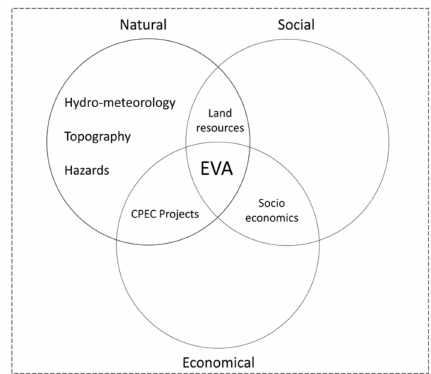
Figure 2. Classification of EVA parameters into several systems.